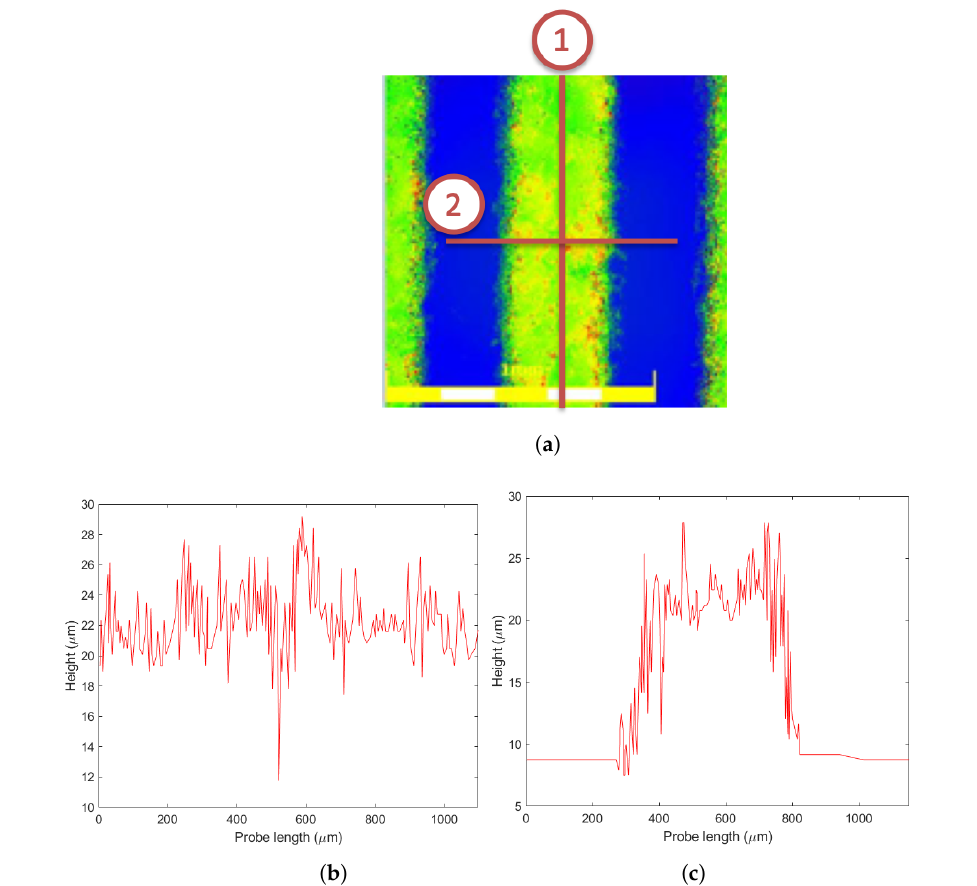
Figure 1. Confocal laser profilometry scanning paths and corresponding height profiles: ( a ) probe paths in the laser profilometry test (Path 1: longitudinal, Path 2: transversal); ( b ) profile from longitudinal Path 1; ( c ) profile from transversal Path 2.